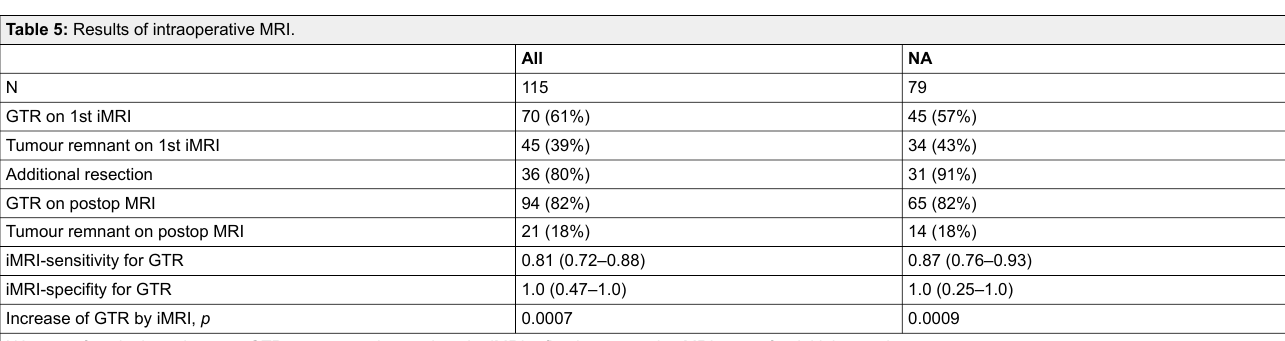
Table 5: Results of intraoperative MRI.